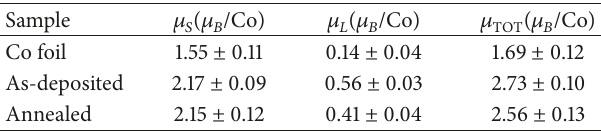
Table 1: Spin ( 𝜇 𝑆 ) and orbital ( 𝜇 𝐿 ) components of the total magnetic momentperCoion( 𝜇 TOT )at4 Kinamagneticfieldof4 Tcalculated using the XMCD sum